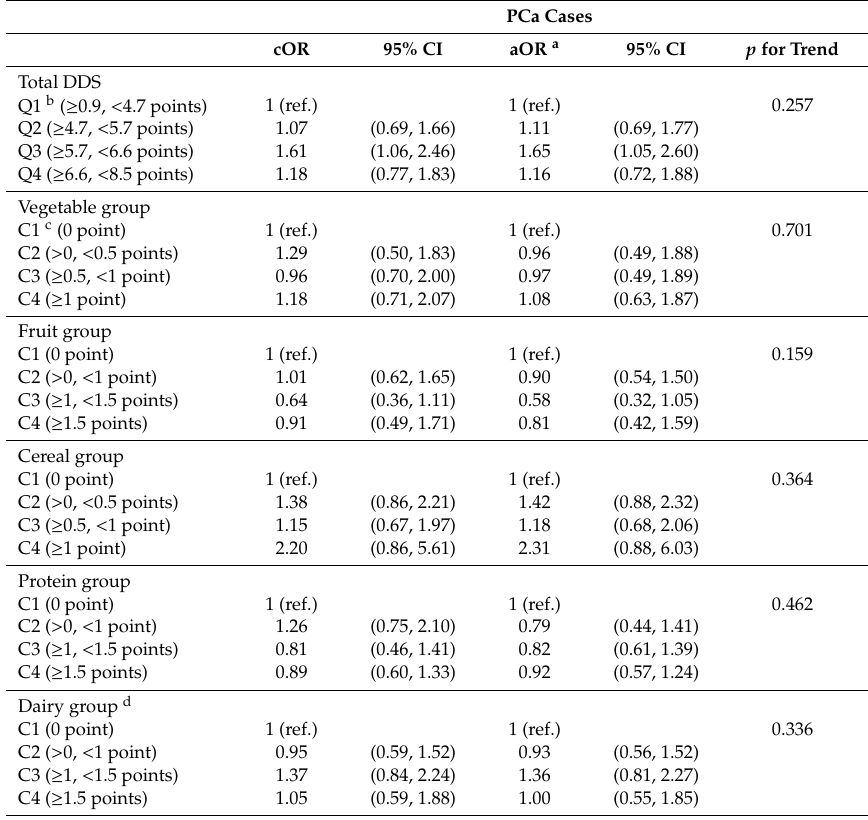
Table 4. Multivariable logistic regression models for the risk of PCa according to the total DDS and variety within the food